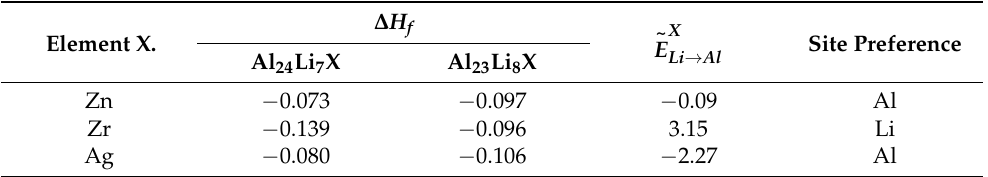
Table 1. Predicted enthalpy of formation ∆ H f (eV), normalized transfer energy (cid:101) E X preference of doped Al 3 Li at 0 GPa.